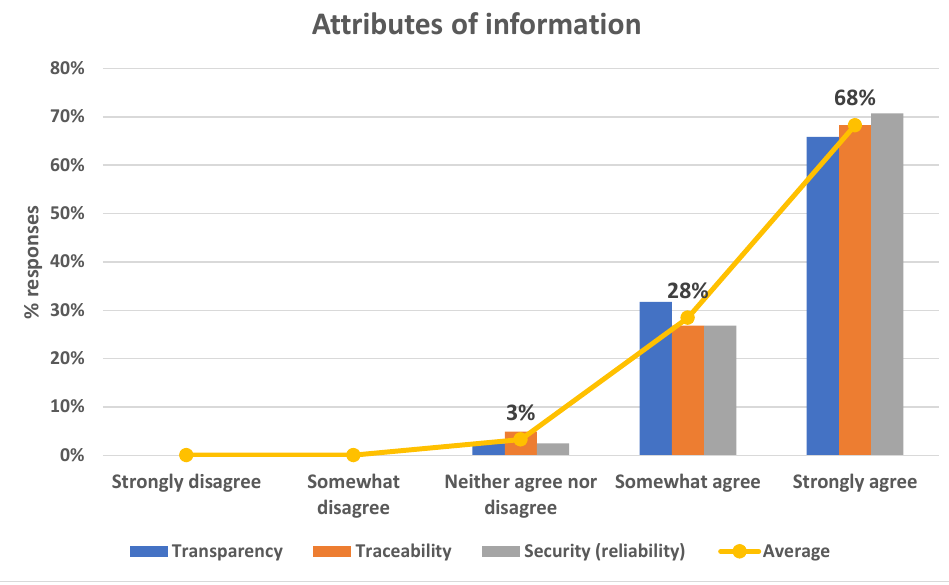
Figure 3. Important attributes of information.